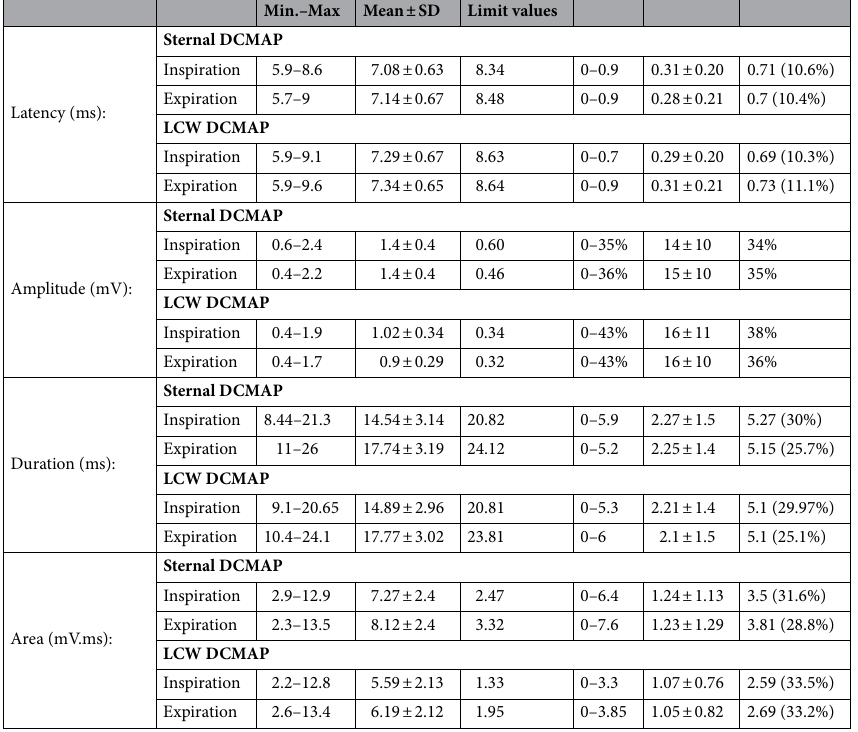
Table 1. The mean, range and normative- interside difference values of sternal and LCW DCMAP parameters during inspiration and expiration. Values determined from 140 phrenic nerves in 70 normal subjects. Normative values determined as mean ± 2SD. Interside amplitude and area differences are expressed as the ratio between the two sides.